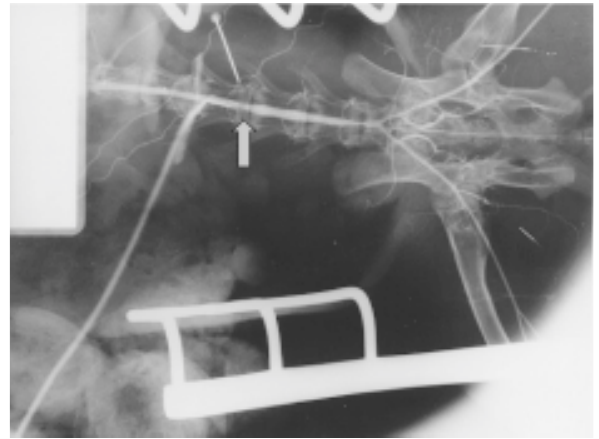
FIGURA 1 – Aortografia de animal do grupo GV – M2. Seta indica linha de sutura com